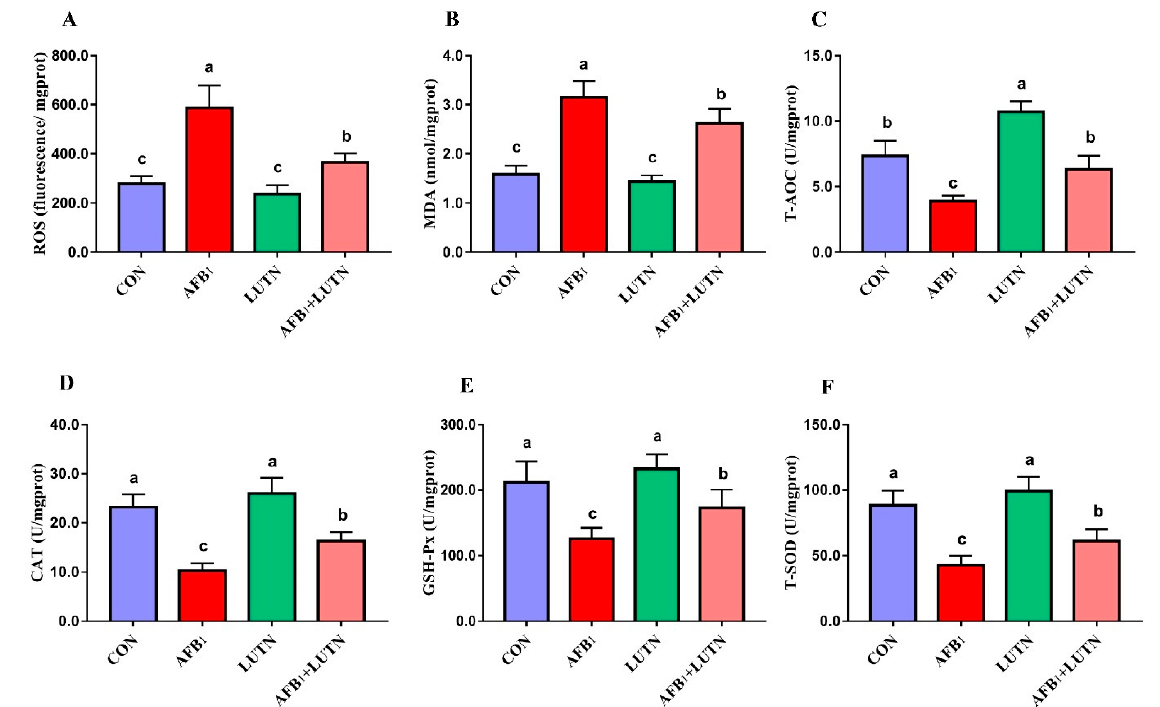
Figure 4. Luteolin treatment ameliorates oxidative damage in the liver of mice induced by AFB 1 . ( A ) Reactive oxygen species (ROS), ( B ) malondialdehyde (MDA) ( C ) total antioxidant capacity (T-AOC), ( D ) catalase (CAT), ( E ) glutathione peroxidase (GSH-Px) and ( F ) total superoxide dismutase (T-SOD). The results are presented as mean ± SD ( n = 6). a–c Columns with different lowercase letters indicated significant differences between the compared groups ( p < 0.05).